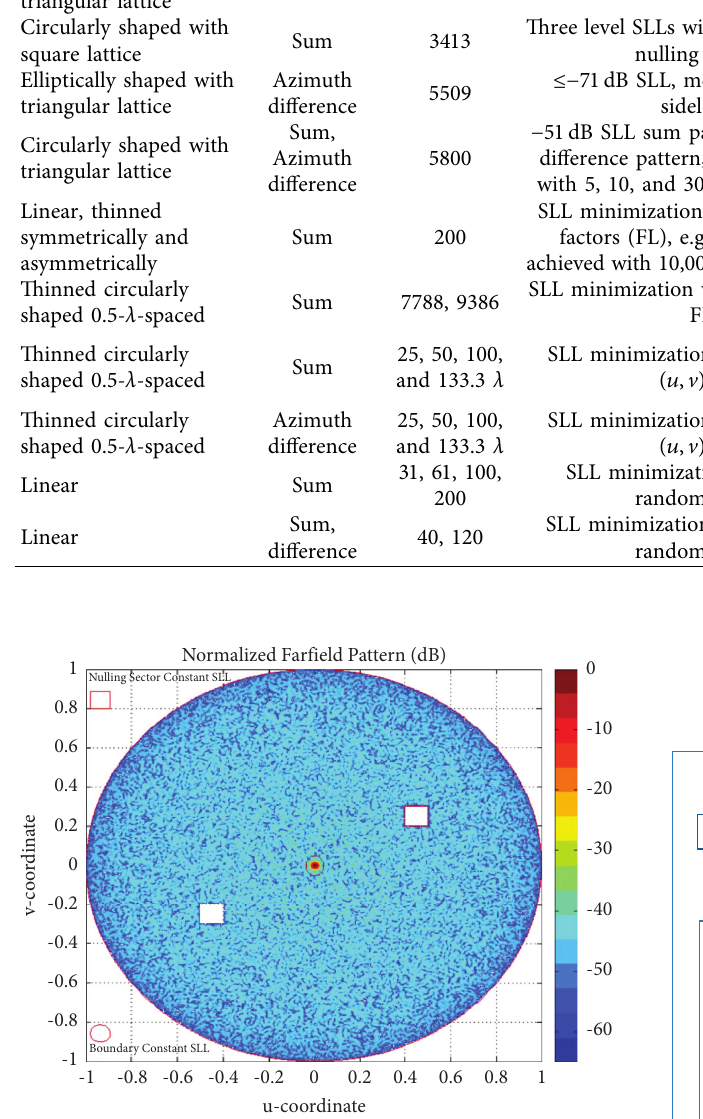
Figure 4: Sum pattern [30] of a thinned 100 λ circular array with 0.5 λ spaced square lattice and 30% FL as synthesized through the IFT technique with an amplitude-only taper. The pattern features a SLL of − 40dB and two 65dB depth nulling sectors.